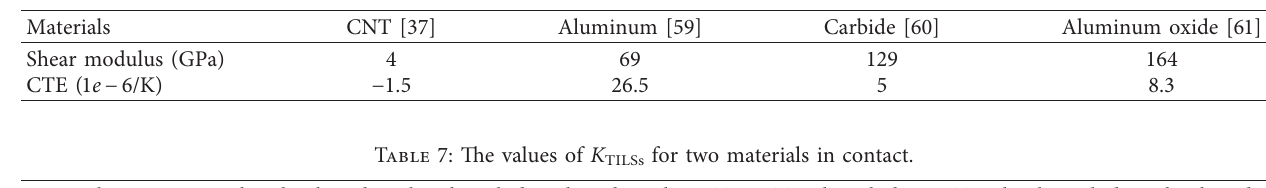
Table 6: Shear modulus and CTEs of CNT, aluminum, carbide, and aluminum